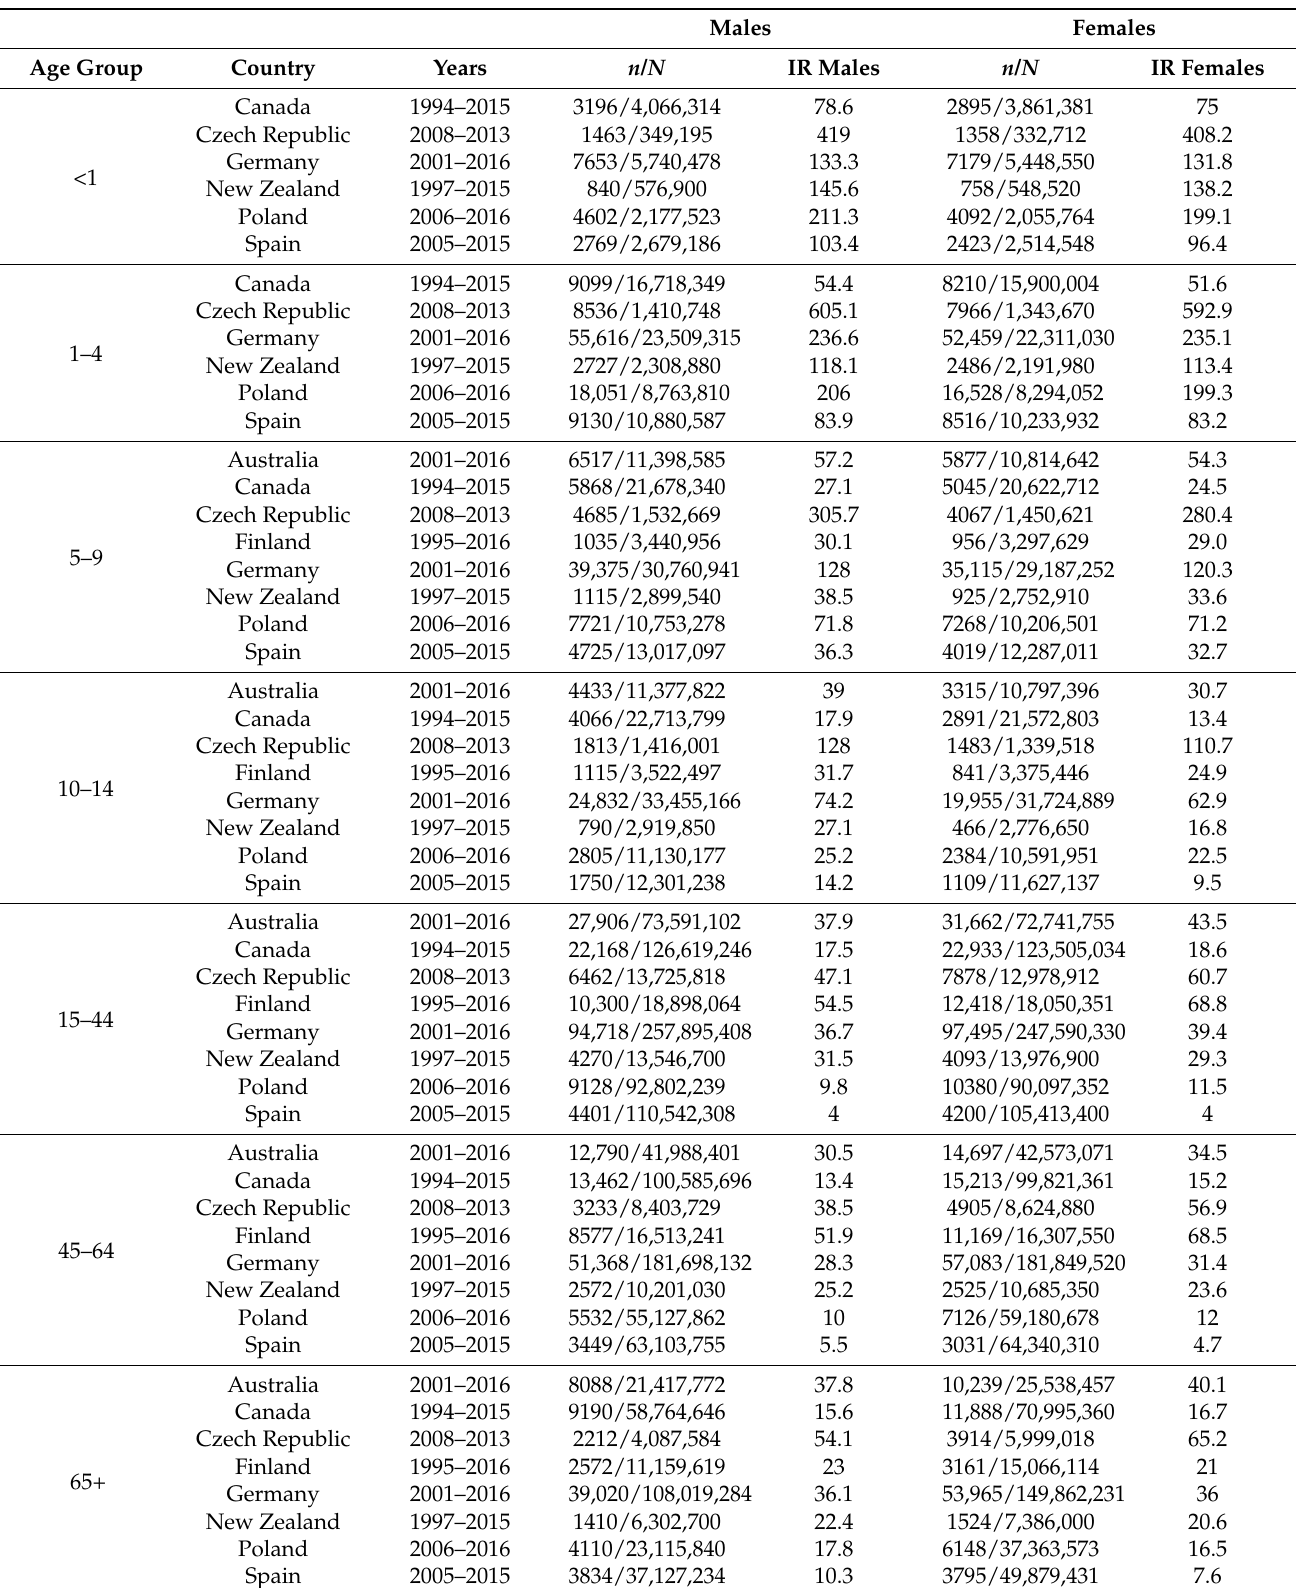
Table 1. Descriptive data: details of the countries included in the analysis, disaggregated by sex and age.